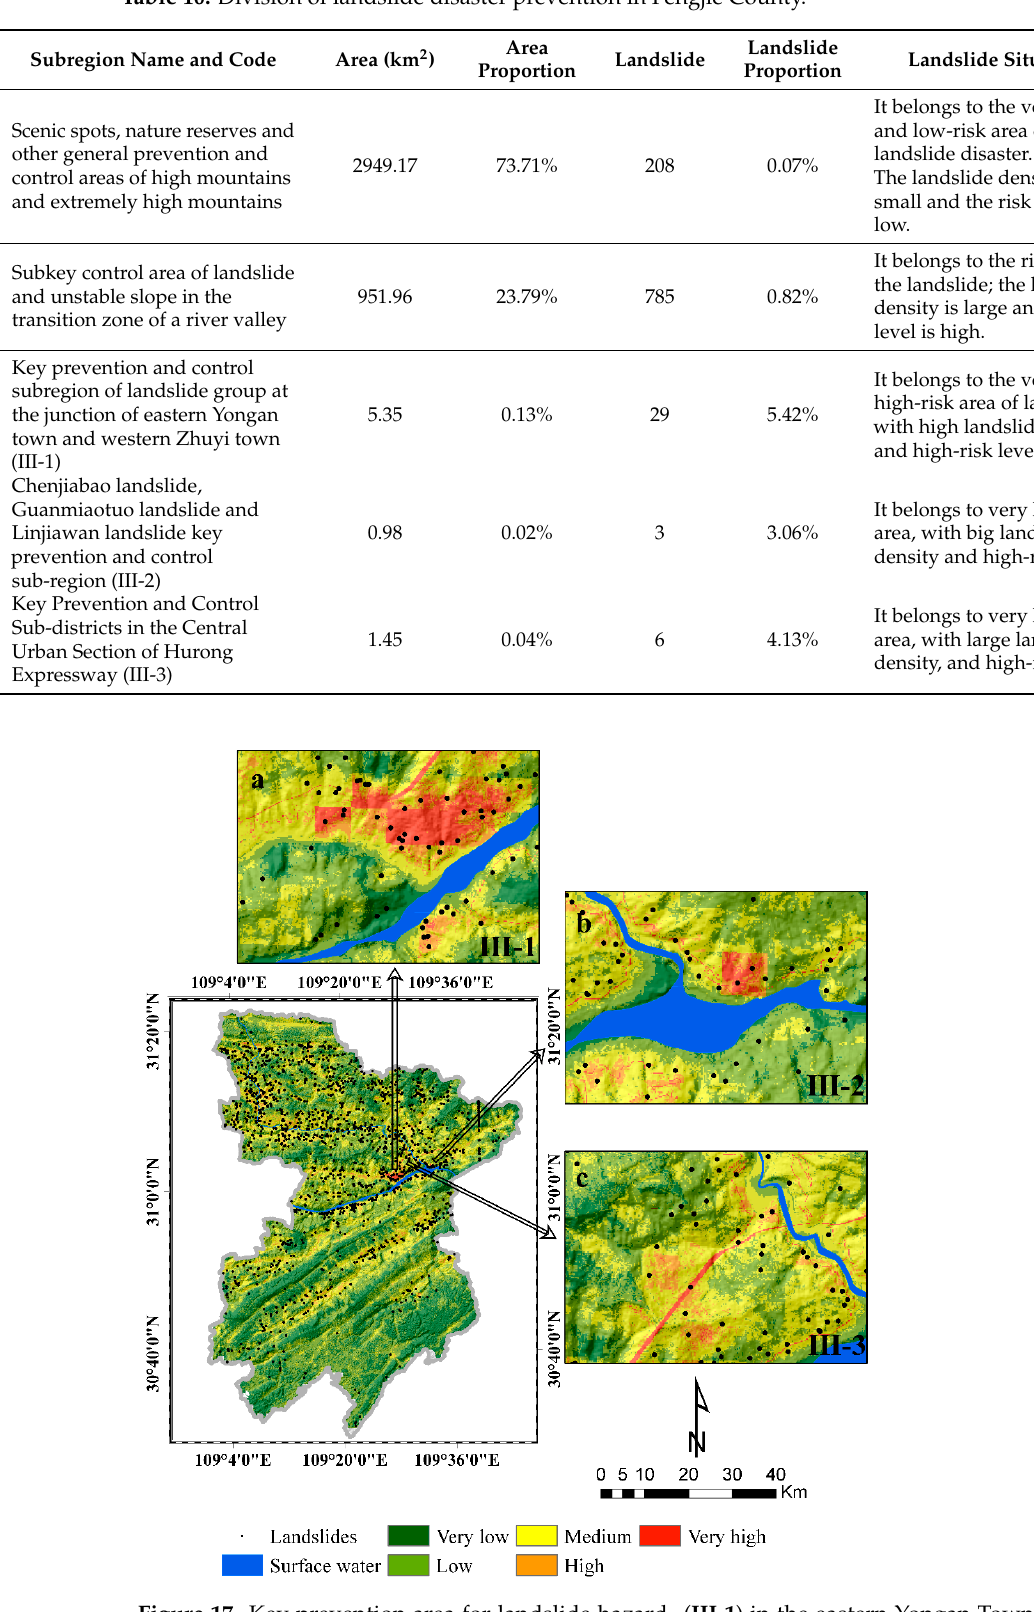
Table 10. Division of landslide disaster prevention in Fengjie County.